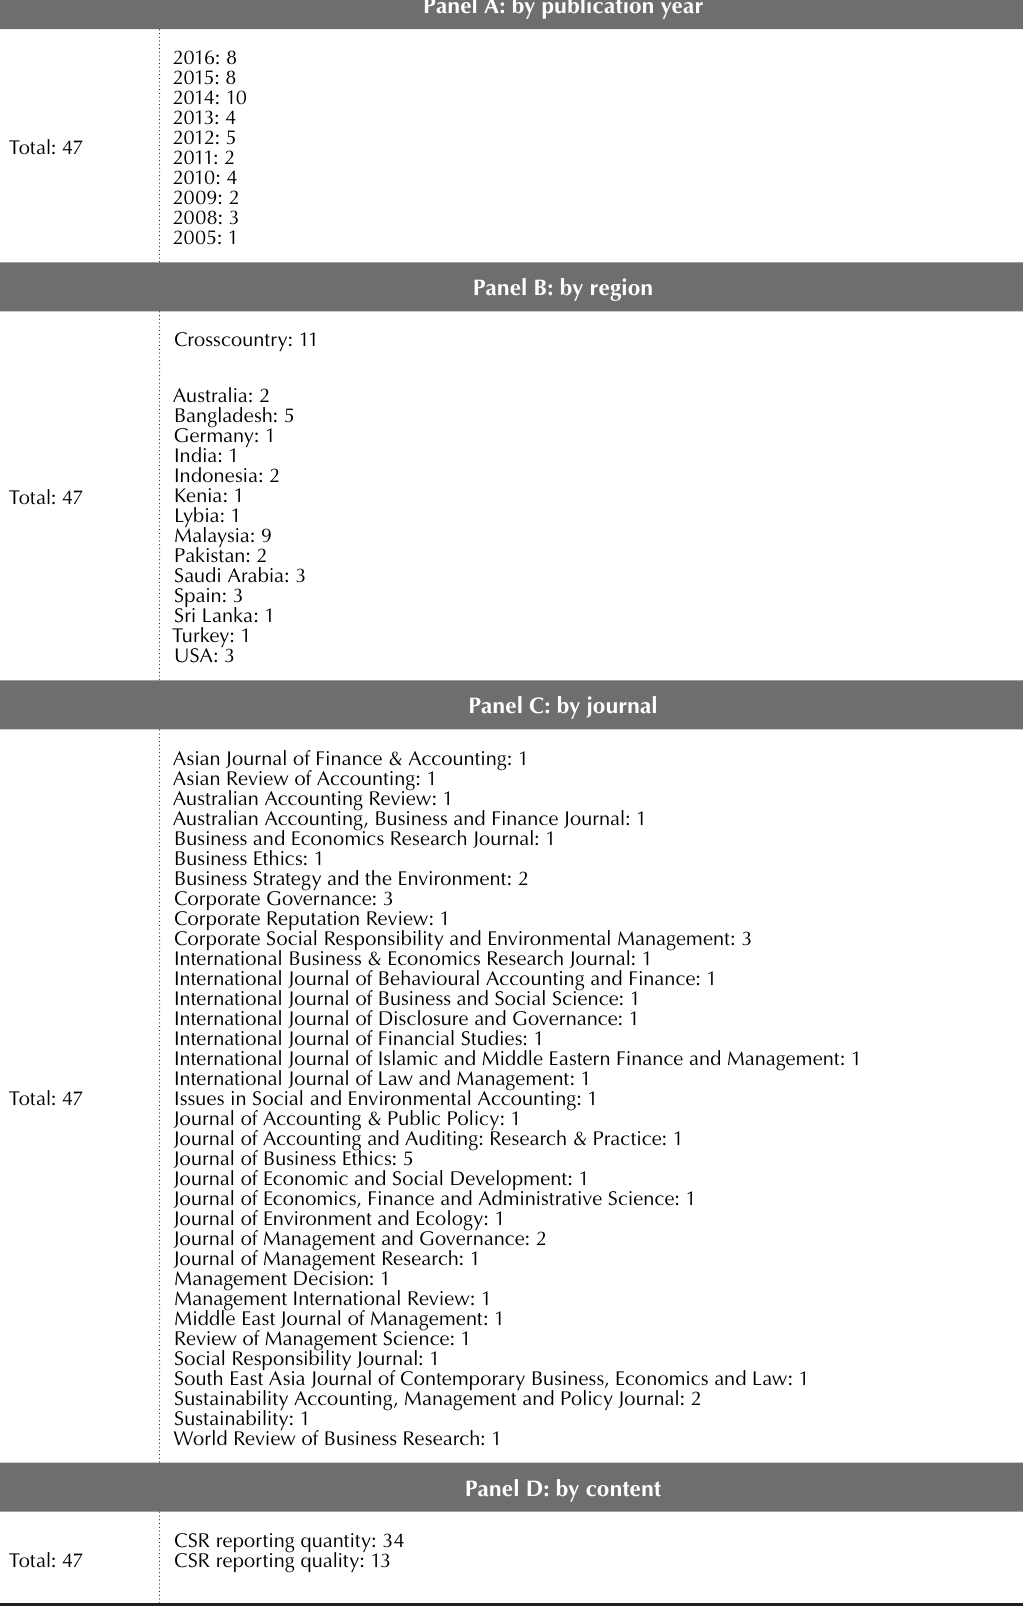
Table 1. Count of cited published papers